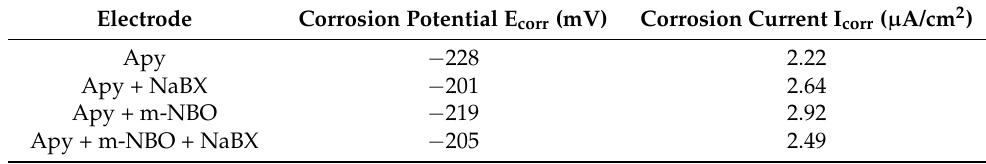
Table 5. The Tafel parameters of the electrode in the pH = 11.5 solution were studied (0.3 mol/L